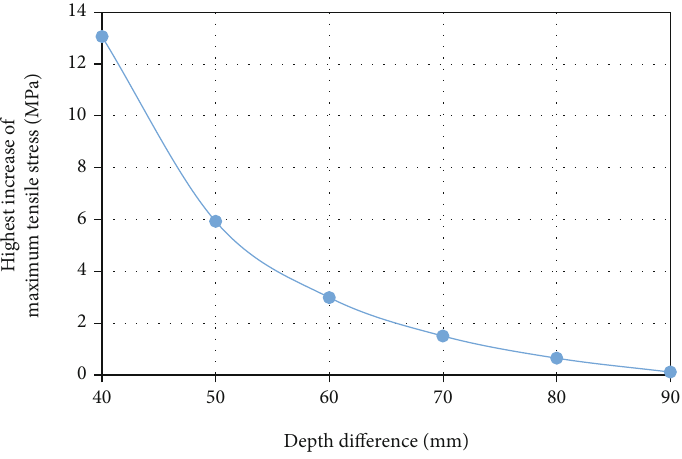
Figure 9: Highest increment of maximum tensile stress with di ff erent depth di ff